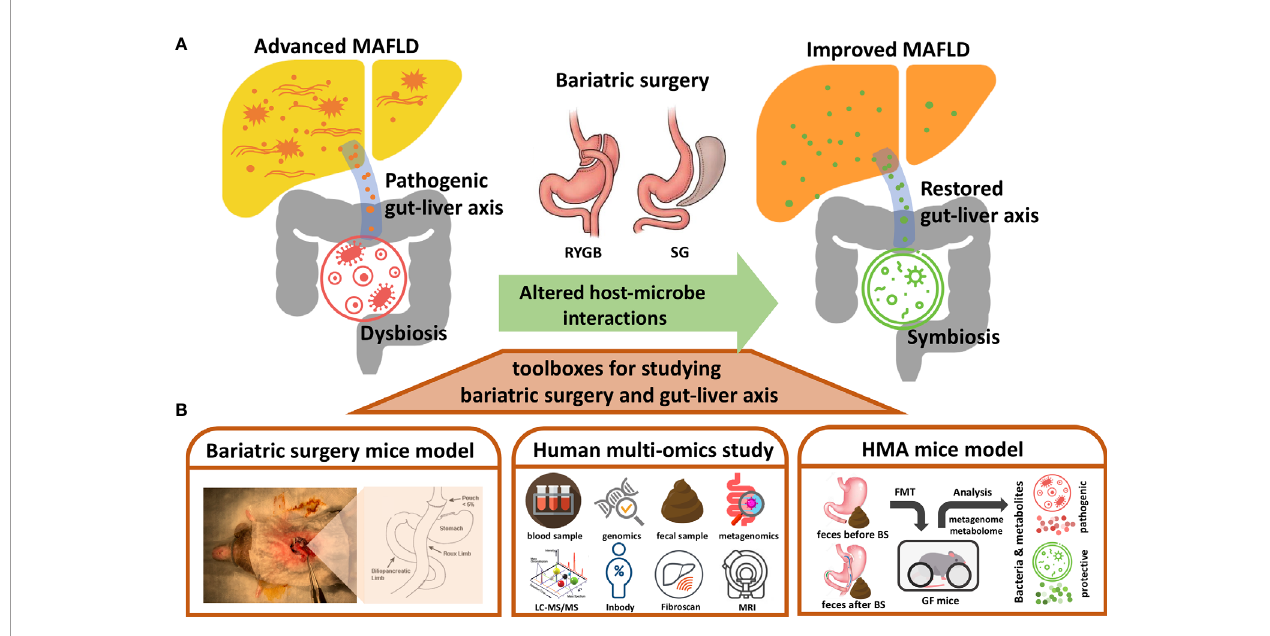
FIGURE 1 | Toolboxes for investigating the bene fi ts of bariatric surgery though gut-liver axis. (A) Diagram illustrating the metabolic bene fi ts of bariatric surgery (BS) for MAFLD could be contributed by the altered host-microbe interactions. The pro-in fl ammatory gut-liver axis from dysbiosis might be restored by the bariatric surgery to improve MAFLD. (B) Approaches presented for studying the altered gut-liver axis by bariatric surgery and its potential bene fi cial effects on MAFLD, including bariatric surgery mice model, human multi-omics study, and human microbiota associated (HMA) mice model. RYGB, Roux-en-Y gastric bypass; SG, sleeve gastrectomy; LC-MS/MS, Liquid chromatography-tandem mass spectrometry; Inbody, a machine used for measuring human body composition; Fibroscan, a machine used for measuring stiffness of liver; MRI, magnetic resonance imaging; FMT, fecal microbiota